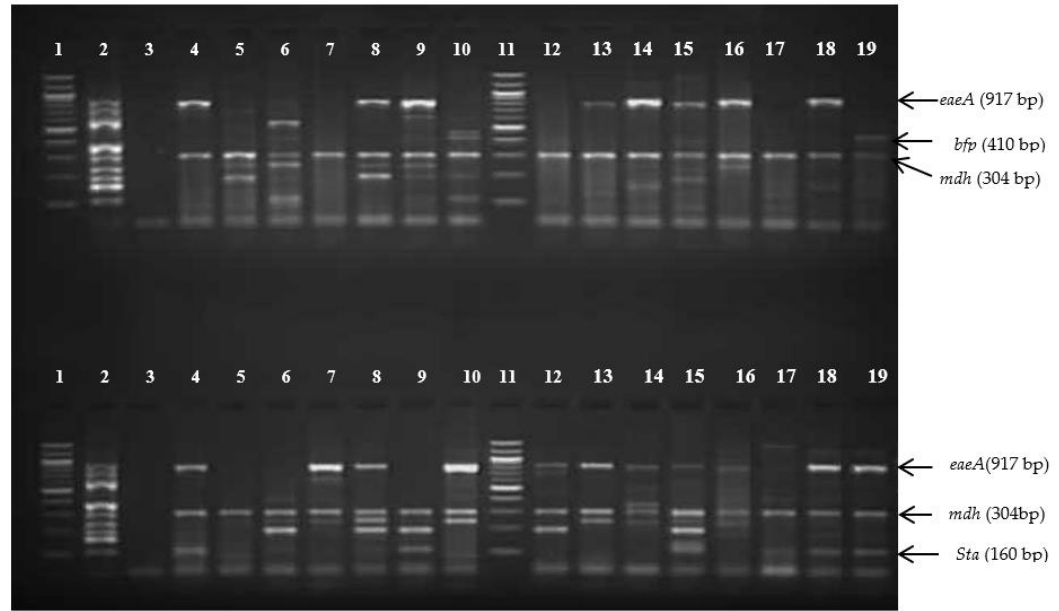
Figure 2. Gel image of m-PCR products of E. coli isolates: Top and Bottom wells: Lanes 1 and 11: 100 bp molecular marker (ladder), Lane 2: positive control, Lane 3: negative control, Lanes 4–10 and Lanes 12–19: E. coli isolates showing different genes. Table 2. Escherichia coli (single pathotype) and their virulence genes detected in this